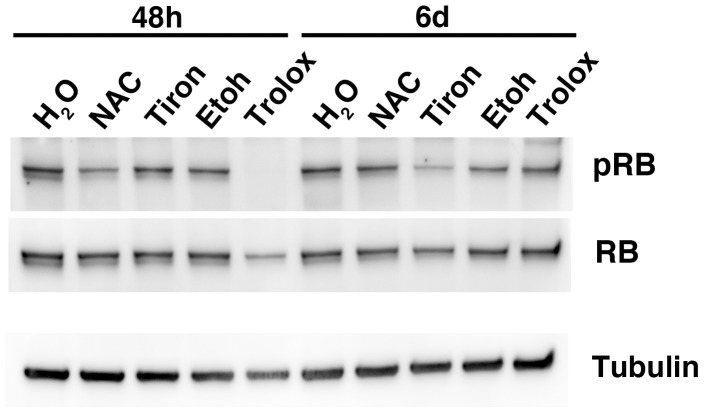
NAC, tiron and trolox treatments of the PT4 cultures containing GBM TICs inhibit the phosphorylation of the retinoblastoma (RB) protein.Western blot analyses were performed with lysates of the PT4 cell culture containing GBM TICs treated for 48 h and 6 days with the indicated antioxidant drug. The membrane was challenged first with an anti phosphorylated RB (Ser 807/811) antibody, then with an anti total RB antibody and lastly with an anti tubulin antibody. Stripping and control of effective stripping were performed before re-challenging of the membrane.